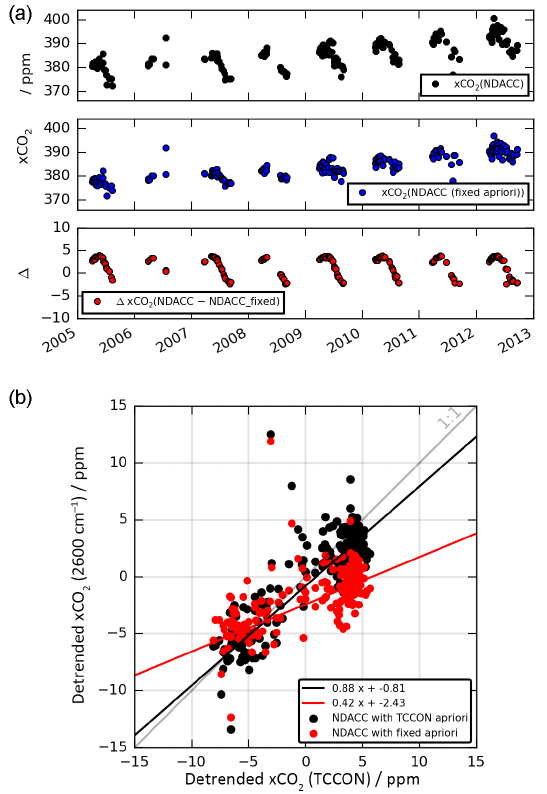
Figure 5. (a) xCO 2 from the 2600cm − 1 NDACC spectra for re- trievals using a modeled (upper panel) and fixed (center panel) a pri- ori and their differences (lower panel). No residual secular trend is evident in the residuum. A clear seasonal pattern is visible, and thus a big part of the seasonal cycle is damped, when using a fixed a pri- ori. (b) The corresponding correlation plot of the de-trended xCO 2 time series of TCCON vs. the NDACC retrievals with modeled and fixed a priori.